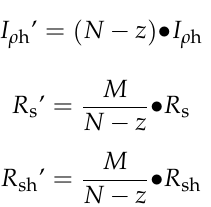
The normal state The short-circuits state The open-circuits state The abnormal aging state